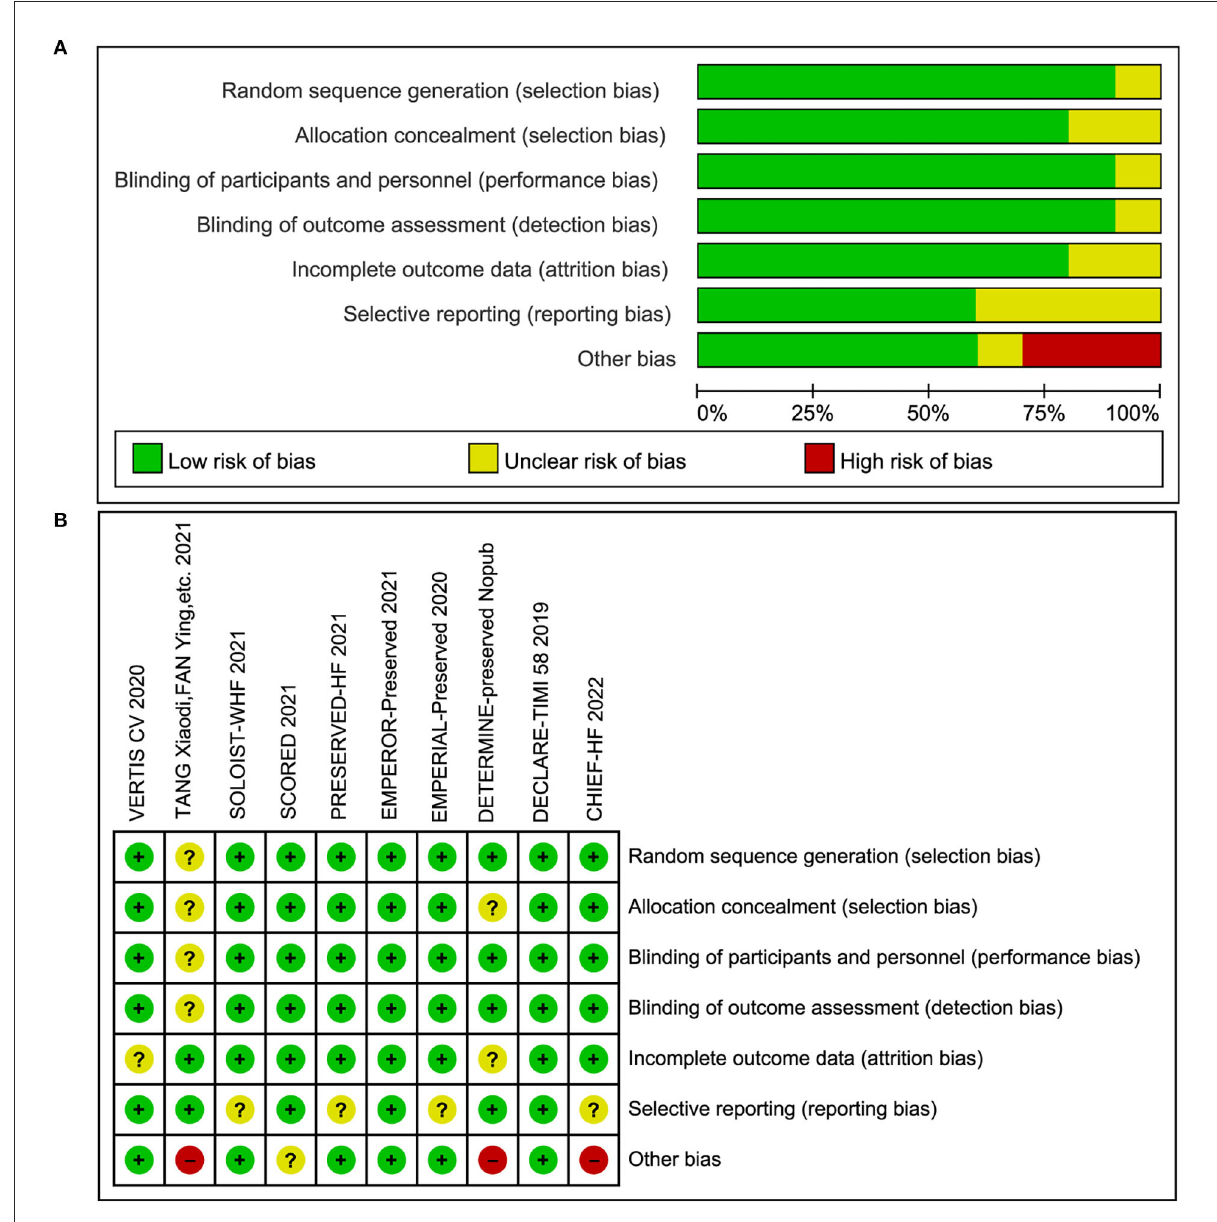
FIGURE2 (A) Risk of bias graph. (B) Risk of bias